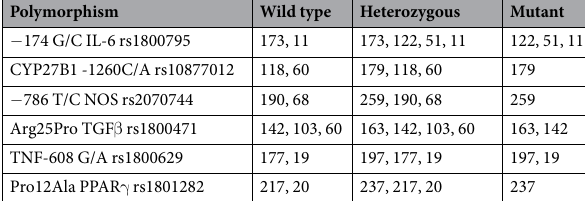
Table 7. Fragments for wild type, heterozygous and